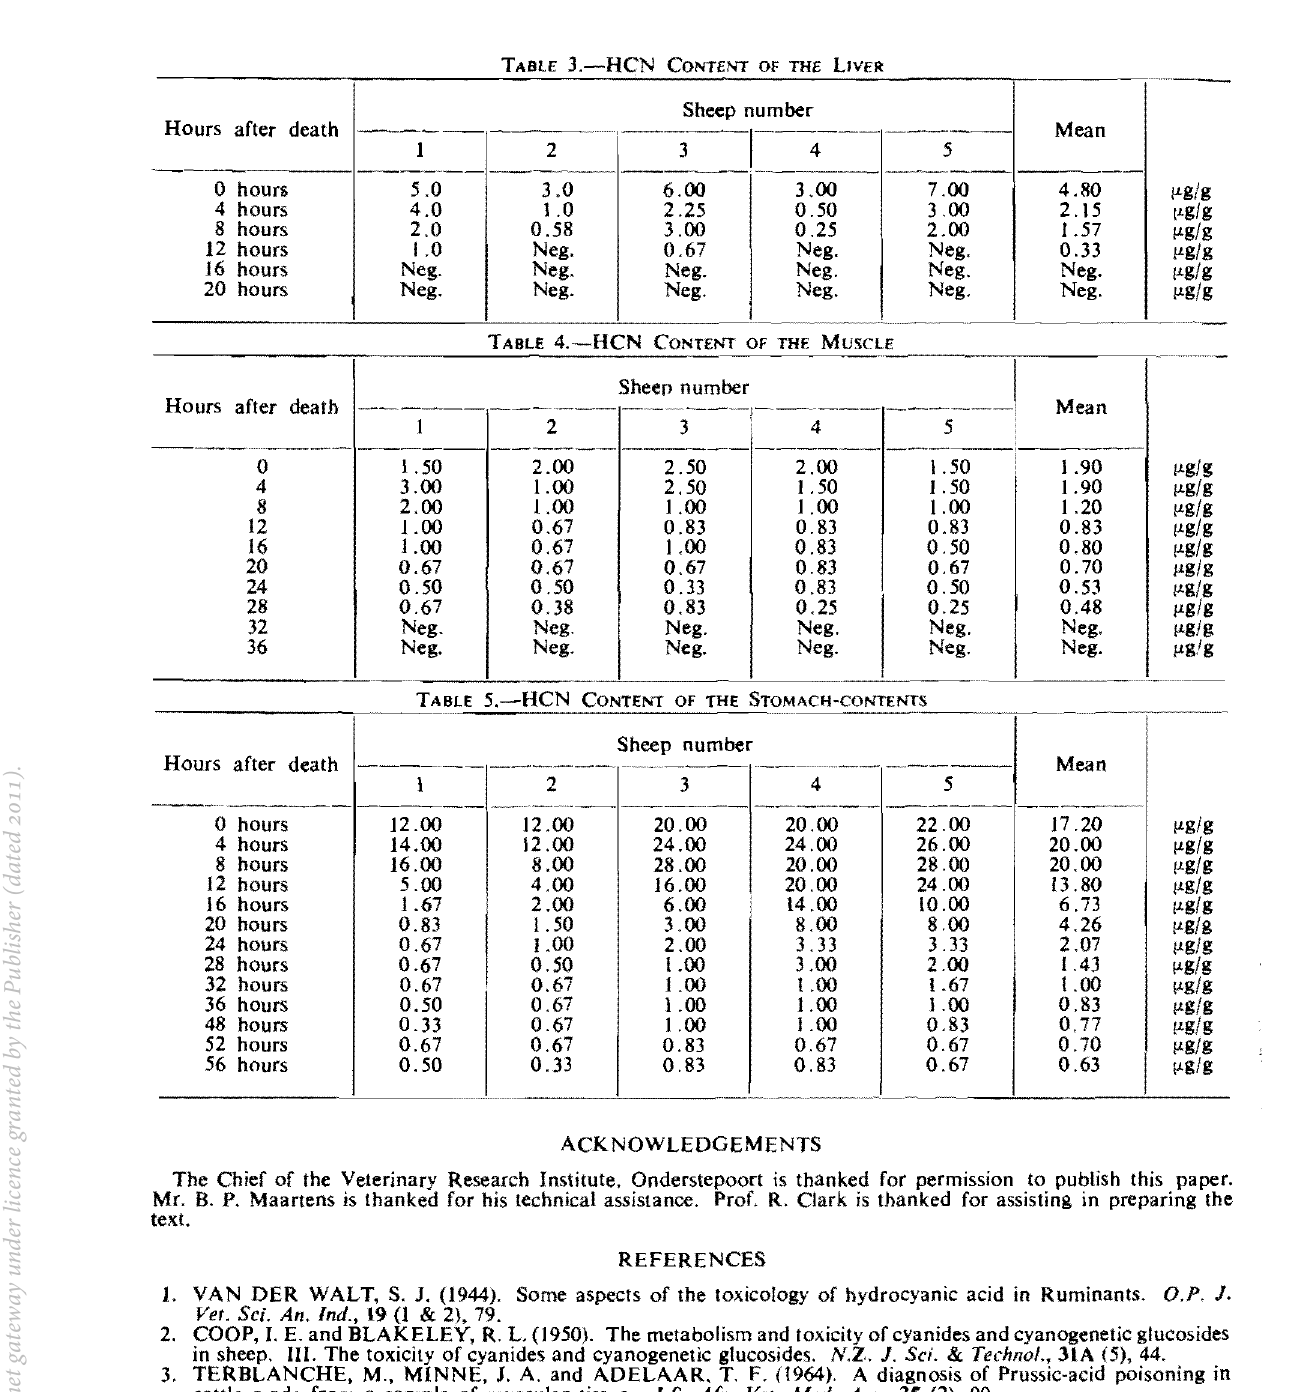
TABLE 4.-HCN CONTENT OF THE MUSClE Sheep number